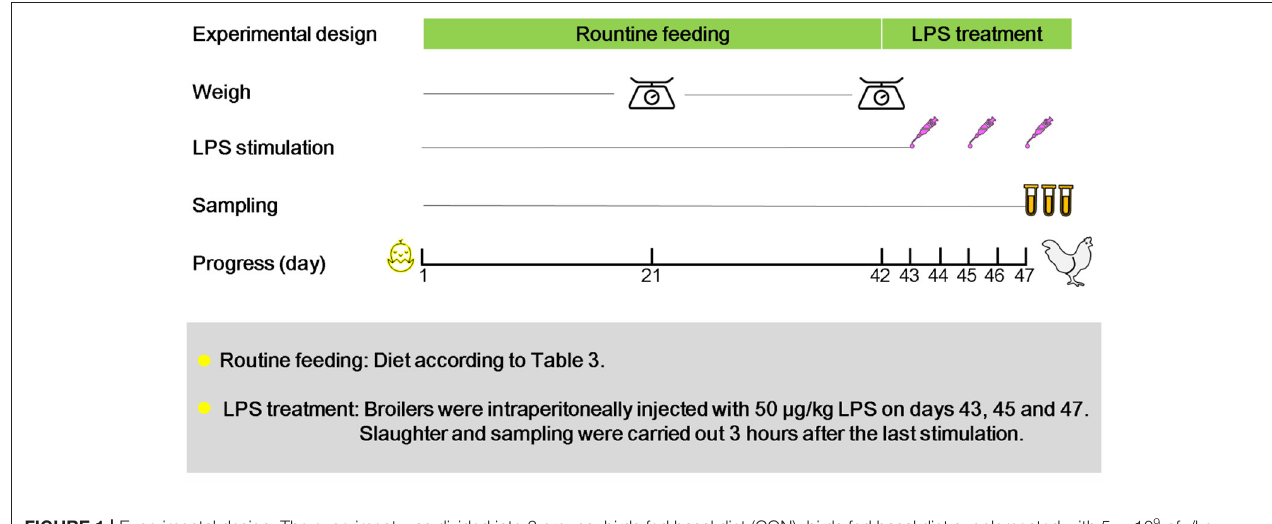
FIGURE 1 | Experimental design. The experiment was divided into 3 groups: birds fed basal diet (CON); birds fed basal diet supplemented with 5 × 10 9 cfu/kg Bacillus coagulans (BC); birds fed basal diet supplemented with 5 × 10 8 cfu/kg Lactobacillus plantarum (LA). All broilers were raised routinely in 1–42 days old, the death and feed intake were recorded daily. Weighing and statistics were conducted on the 21st and 42nd day. TABLE 1 | Raw material composition and nutritional level of basic dietary (air-dry